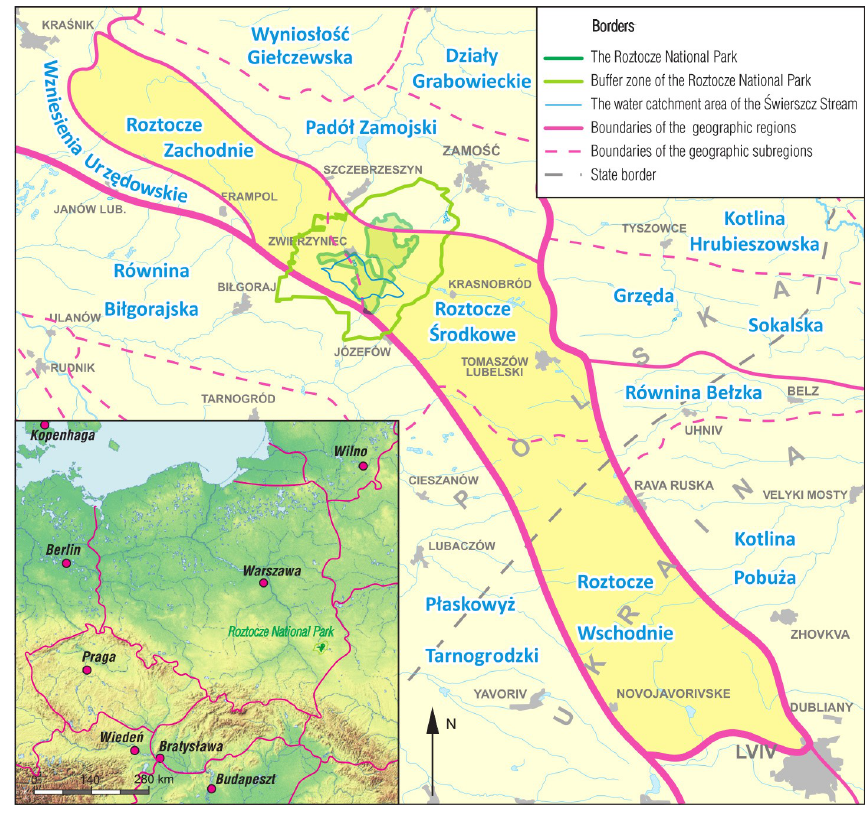
Figure 1. Physico-geographic regionalization and location of the Roztocze National Park in Roztocze